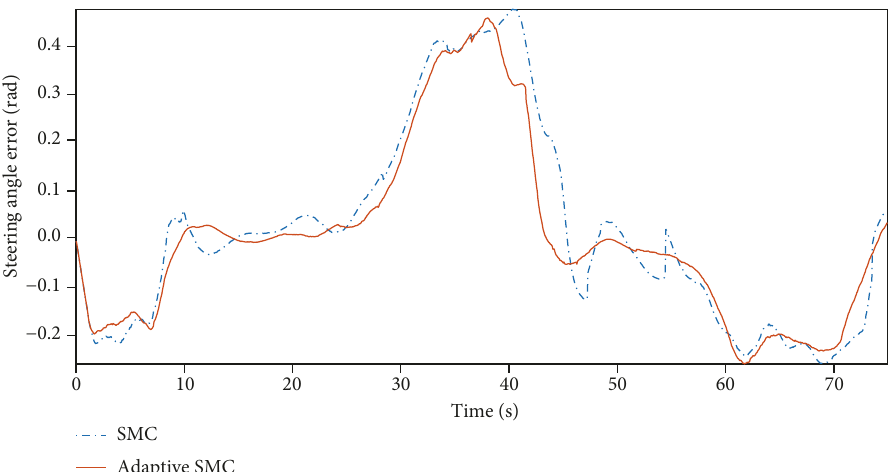
Figure 17: The comparison of steering angle with SMCs.